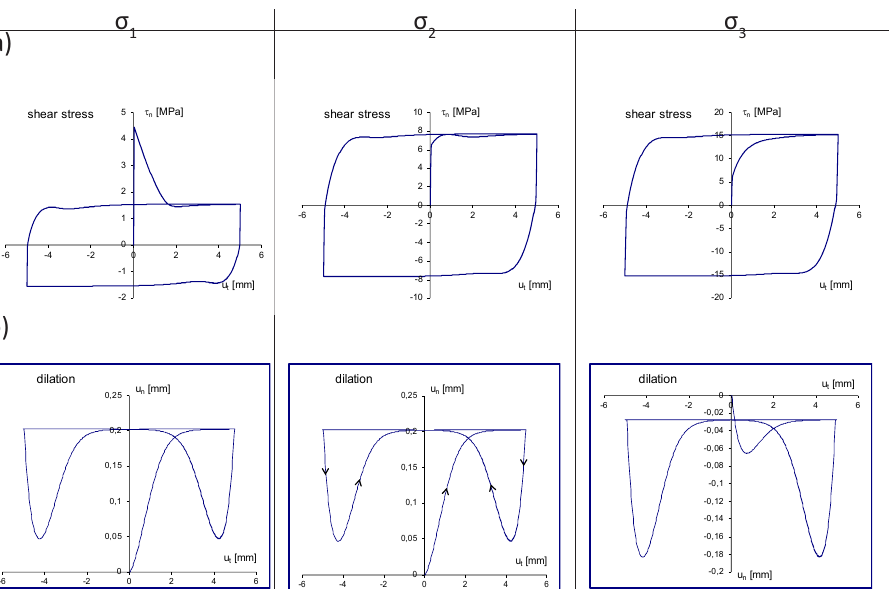
= 25° ) depending on the tangential displacement max